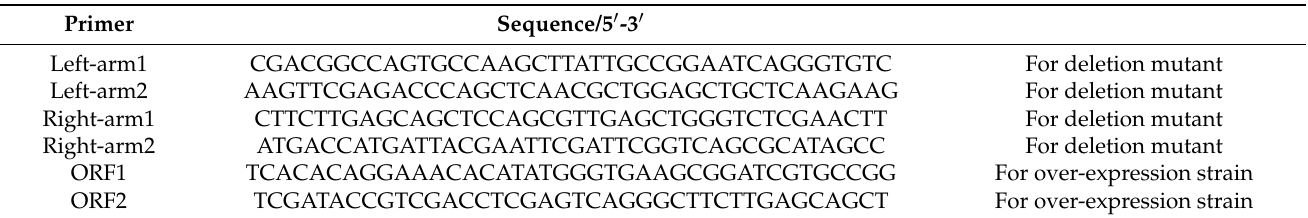
Table 1. Primers used for construction of deletion mutant and over-expression strain in this study. Primer Sequence/5 (cid:48) -3